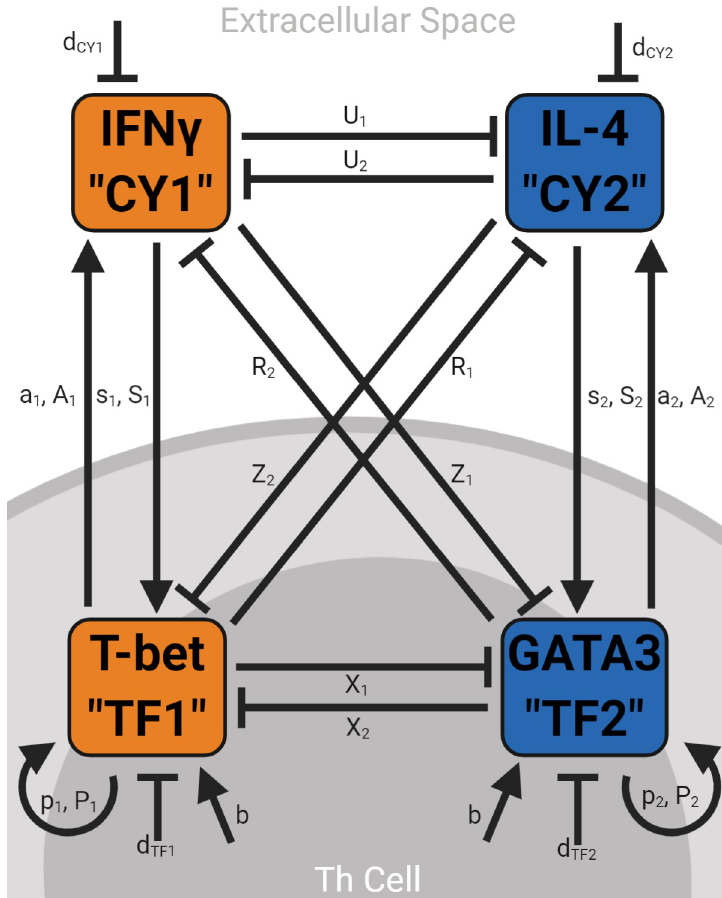
Fig 1. Model schematic. T-bet and GATA3 are the master transcription factors controlling Th1 and Th2 differentiation, respectively, and are confined within Th cells. IFN γ and IL-4 are the master cytokines controlling Th1 and Th2 differentiation, respectively, and are free to diffuse through the extracellular space. Together, expression of these four molecules are the four state variables of the dynamic model. Each of these four molecules can upregulate (arrow-head interactions) or downregulate (T-head interactions) the expression of the other molecules in the model. References to the immunological literature supporting the existence of the depicted interactions and their assigned parameter values are provided in S1